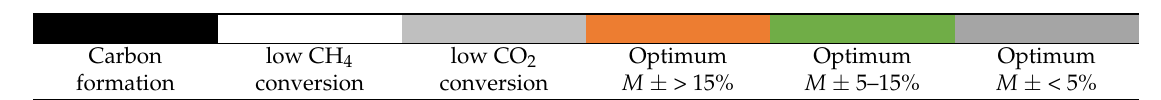
Table 6. Legend for following contour Table 6 . Legend for following contour plots.